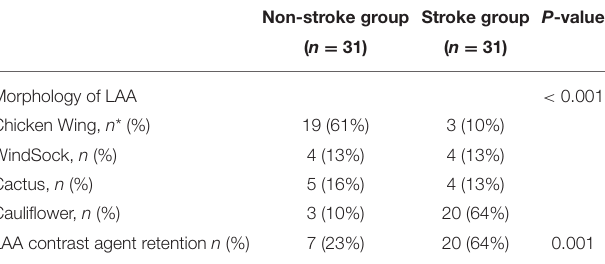
TABLE 2 | LAA angiography data.